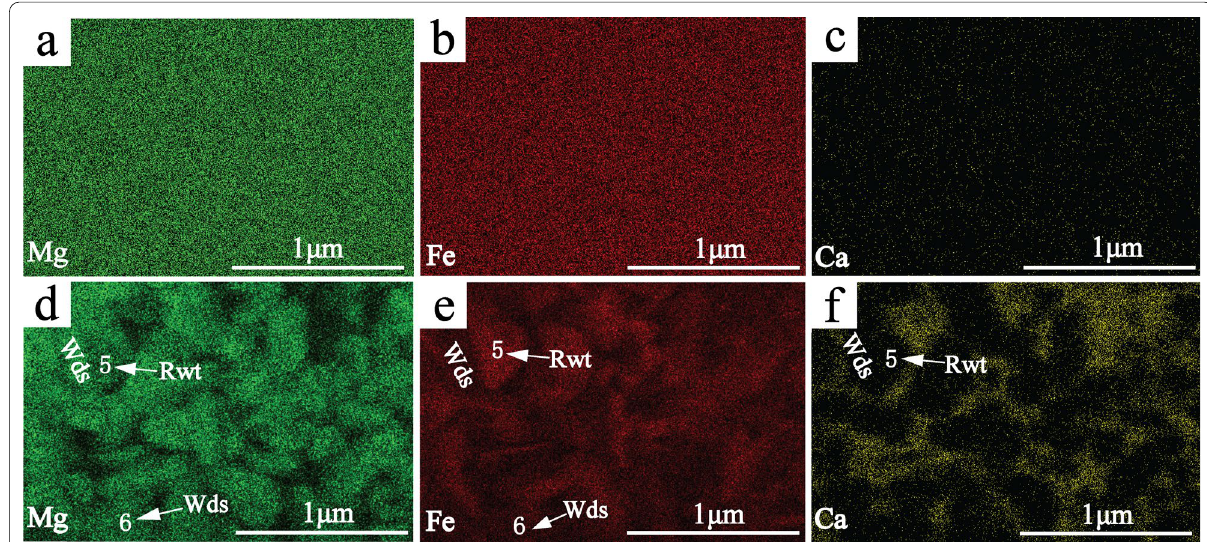
Fig. 6 TEM–EDS elemental mapping images of Mg, Fe, and Ca of polycrystalline ringwoodite and matrix (Mtx). a – c Elemental mapping images of Fe, Mg, and Ca for polycrystalline ringwoodite in Fig. 5b show the homogeneous composition distribution. d – f Elemental mapping images of Fe, Mg, and Ca in the matrix from white dotted-line box in Fig. 5d shows that the distributions of Fe, Mg, and Ca are heterogeneous. Between the ringwoodite and wadsleyite, there exists Ca-rich interstitial material